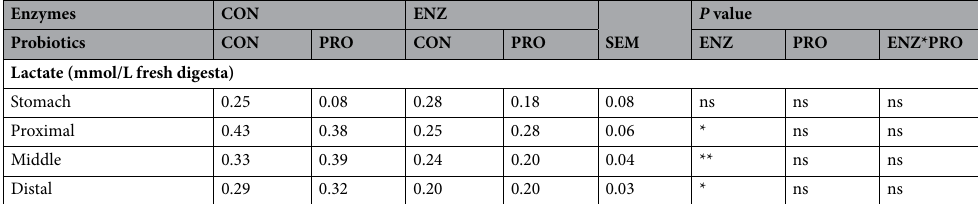
Table 2. The lactic acid content in fresh chyme along the gastrointestinal tract of Nile tilapia. CON, no supplementation; ENZ, enzyme (effect) supplementation; PRO, probiotic (effect) supplementation; ENZ*PRO,